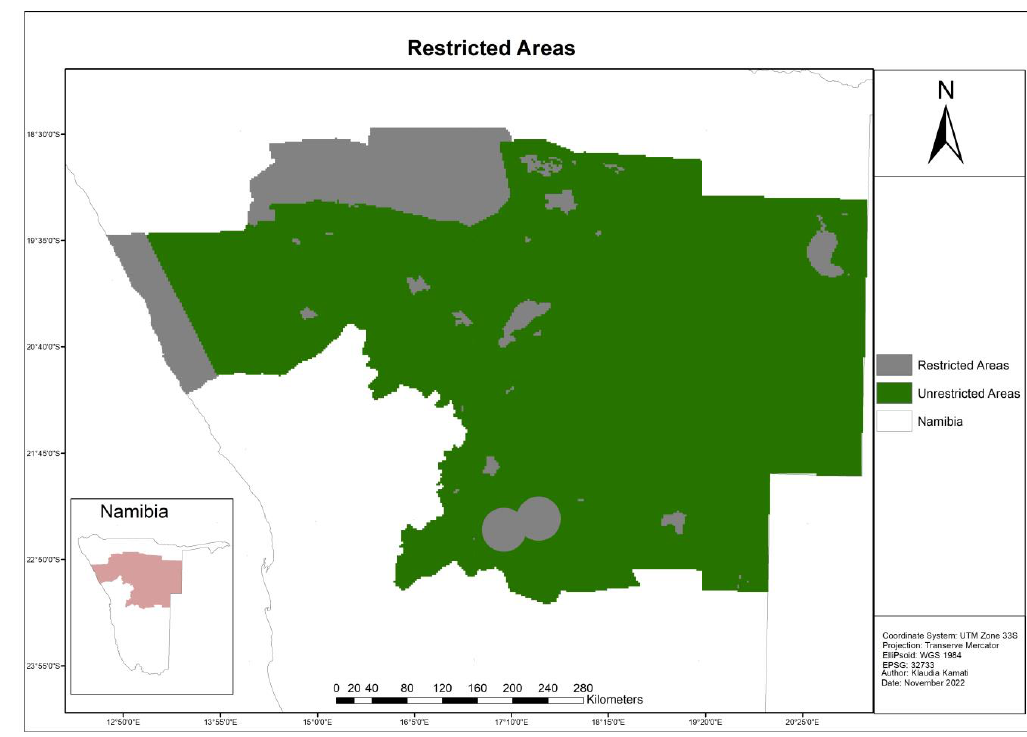
Figure 6. Restricted and unrestricted areas in the study region.